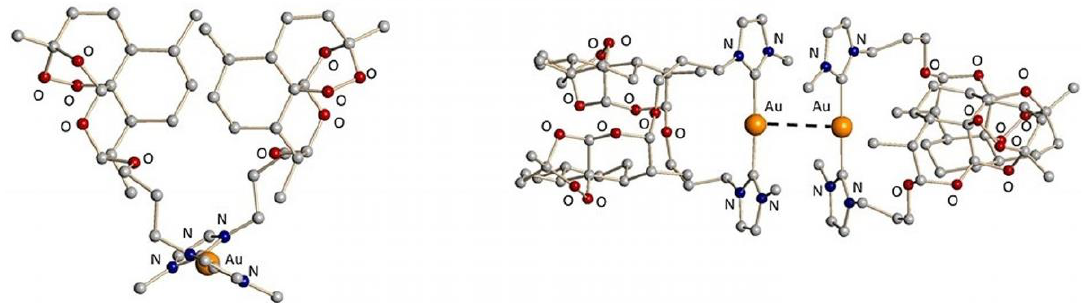
Figure 43. Structure of the cationic part of the complexe 2a in the solid state. One bisNHC–gold unit looking along the C-Au-C axis on the left and dimeric arrangement on the right.